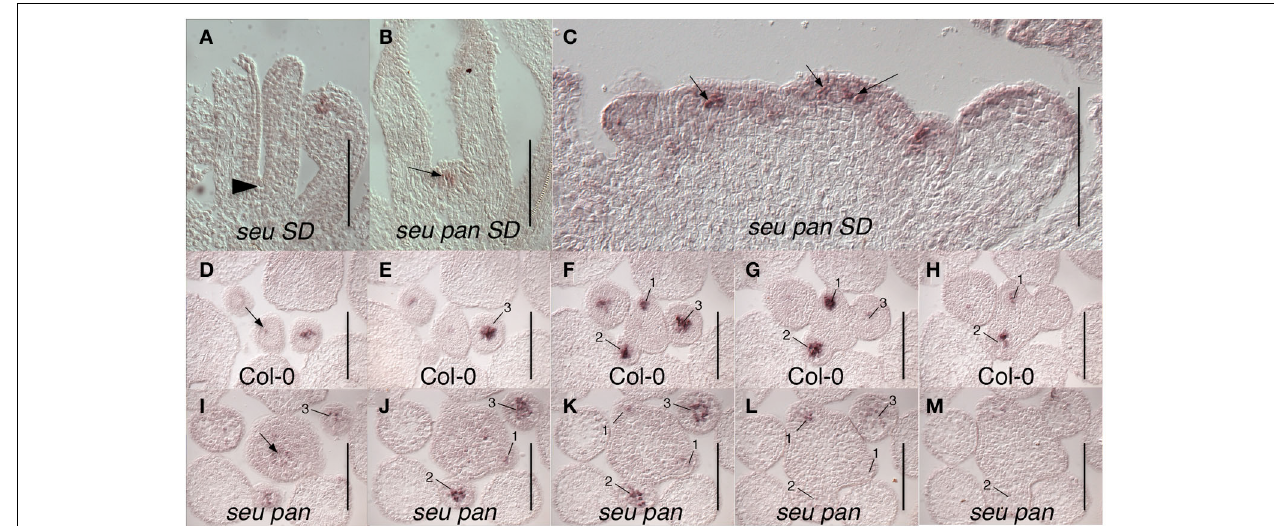
FIGURE 4 | WUS expression in seu pan double mutants. (A) No WUS expression is detected at the base of the stage 8 gynoecium (arrowhead) in this longitudinal section of a Col-0 flower. (B) WUS expression is detected in fifth whorl structure (arrow) at the base of the stage 8 seu pan gynoecium. (C) Longitudinal section of a fasciated inflorescence meristem (IFM) from seu pan double mutant where WUS expression appears in multiple foci (arrows) as well as diffusely throughout IFM. (D–M) Serial cross sections through Col-0 (D–H) and